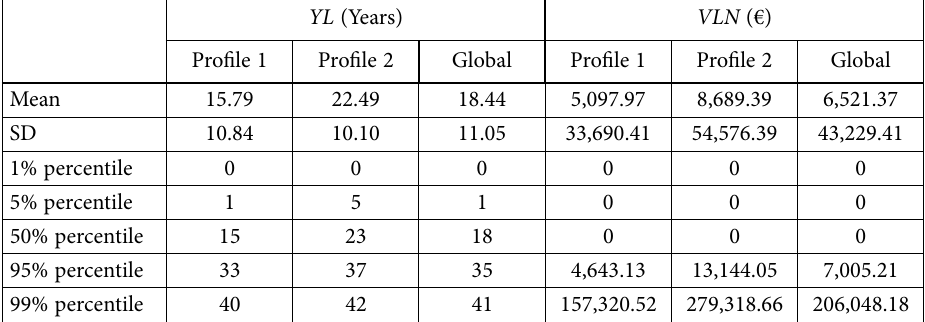
Table 4. Statistics of YL and VLN without RM (source: own elaboration) YL (Years) VLN (€) Profile 1 Profile 2 Global Profile 1 Profile 2 Global Mean